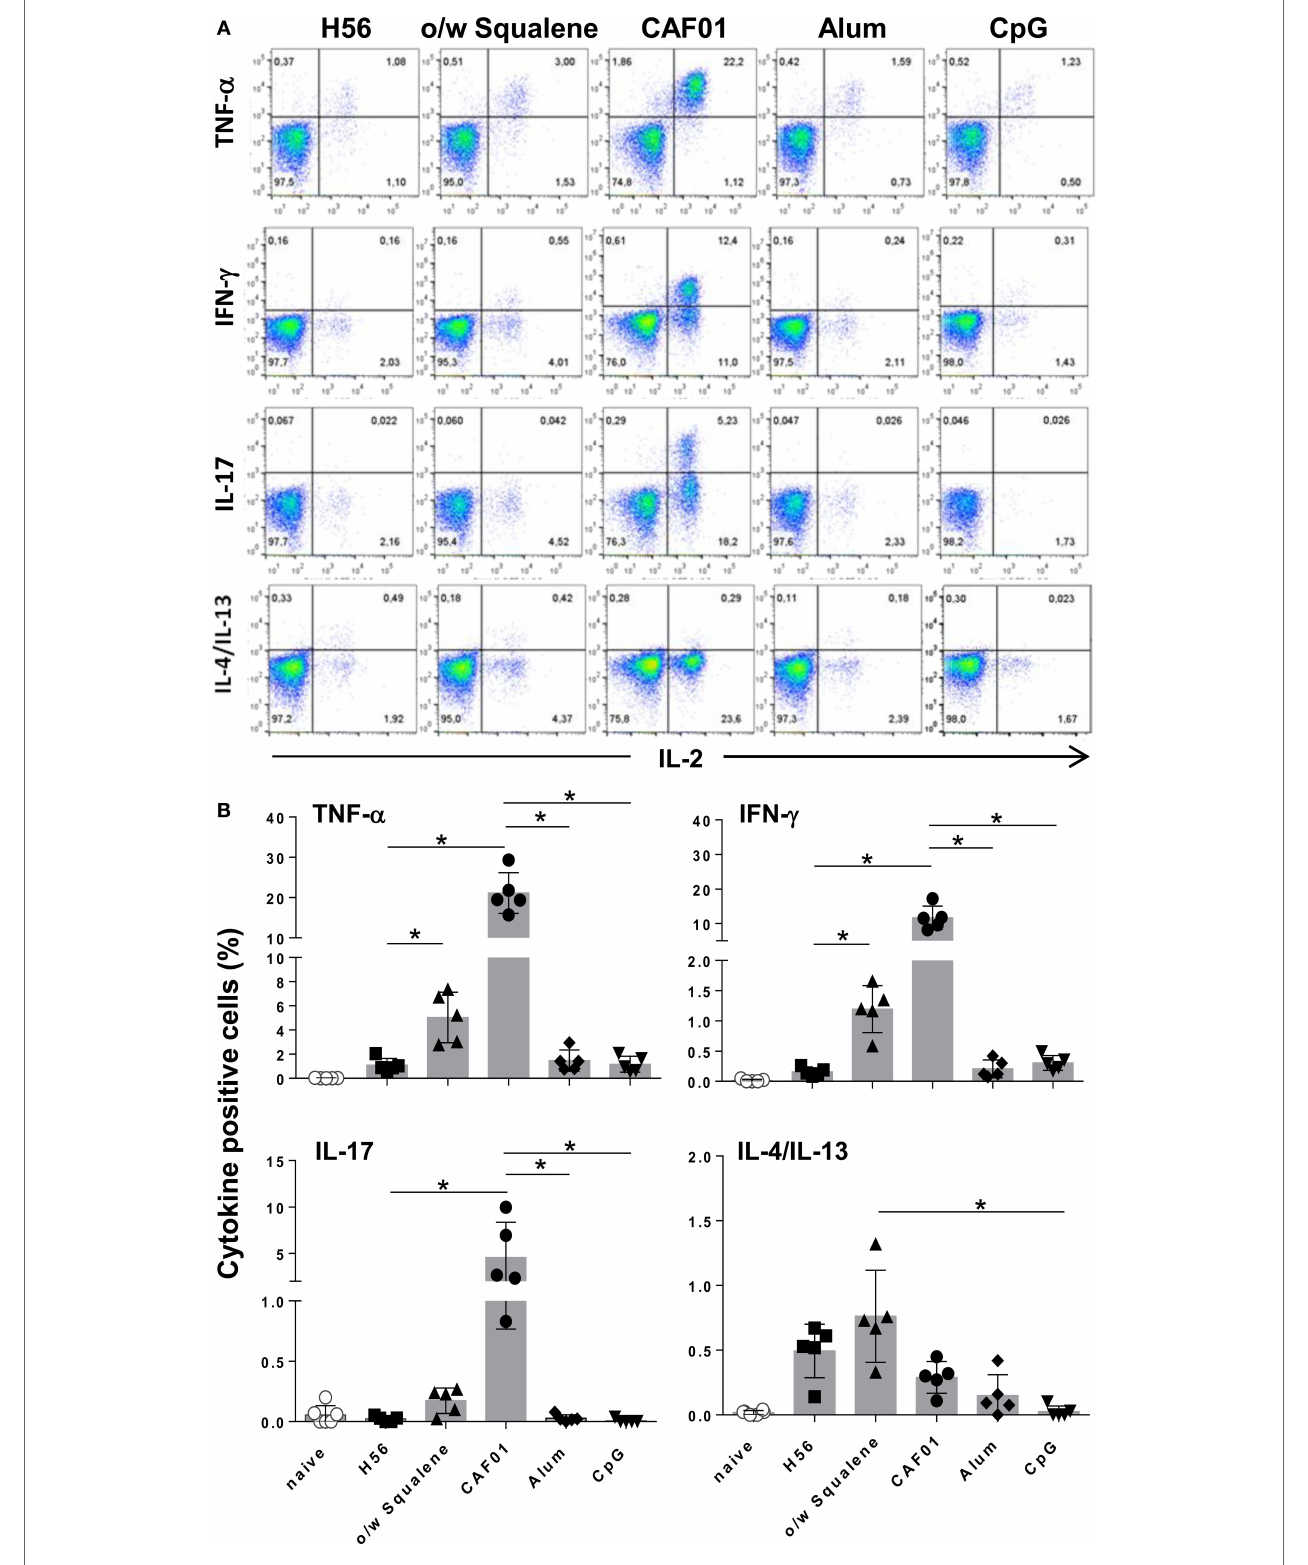
FigUre 2 | intracellular cytokines production